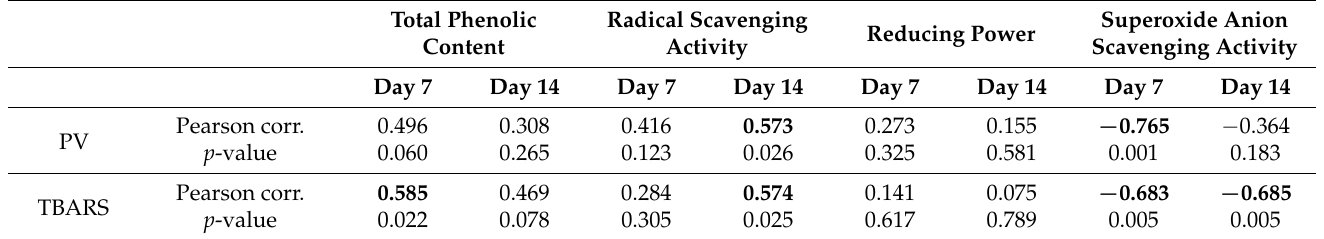
Table 3. Correlation between lipid oxidation day 7 and day 14 measured as peroxide value (PV) and thiobarbituric acid reactive substances (TBARS) and total phenolic content and antioxidant capacity of sage measured as, radical scavenging activity determined via a modified 2,2-diphenyl-1- picrylhydrazyl (DPPH) method, reducing power, and superoxide anion scavenging activity, respec- tively; n = 15. Significant correlations in